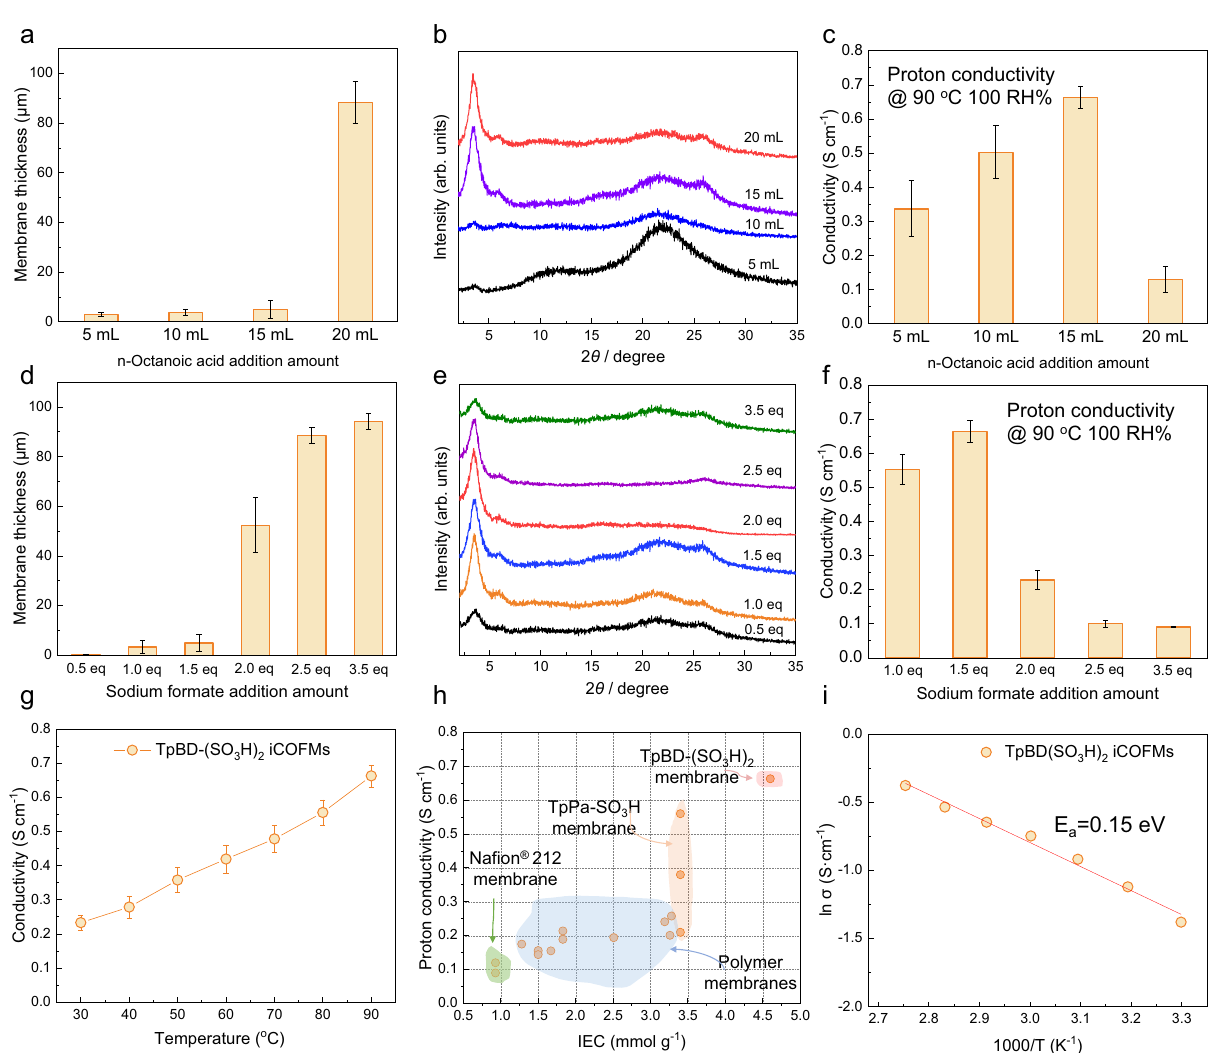
Fig. 4 Membrane structure manipulation and proton conductivity evaluation. a – c Effect of the n-octanoic acid addition amount on ( a ) thickness, ( b ) crystallinity, and ( c ) proton conduction performances of the TpBD-(SO 3 H) 2 iCOFMs. Curves in ( b ) are the PXRD patterns of TpBD-(SO 3 H) 2 iCOFMs fabricated with the n-octanoic acid addition amount of 5 mL (black), 10 mL (blue), 15 mL (purple), and 20 mL (red). In this experiment, 1.5 equivalents (eq) of sodium formate were added to the water phase as the amine monomer activator. d – f Effect of the sodium formate addition amount on ( d ) thickness, ( e ) crystallinity and ( f ) proton conduction performances of the TpBD-(SO 3 H) 2 iCOFMs. Curves in ( e ) are the PXRD patterns of TpBD-(SO 3 H) 2 iCOFMs fabricated with the sodium formate addition amount of 0.5 eq (black), 1.0 eq (orange), 1.5 eq (blue), 2.0 eq (red), 2.5 eq (purple), and 3.5 eq (green). In this experiment, 15 mL of n-octanoic acid were added to the organic phase as the aldehyde monomer activator. g Temperature-dependent proton conductivity of the TpBD-(SO 3 H) 2 iCOFMs fabricated at optimized condition (the addition amount of n-octanoic acid and sodium formate was 15 mL and 1.5 eq, respectively). h IEC value versus proton conductivity for polymer membranes, previously reported iCOFMs and the TpBD-(SO 3 H) 2 iCOFMs (detailed data was provided in Supplementary Table 9). i Proton-transfer activation energy ( E a ) of the TpBD-(SO 3 H) 2 iCOFMs fabricated at optimized condition. All the error bars in this fi gure represent the standard deviation ( n = 3 independent experiments), data are presented as mean values ±